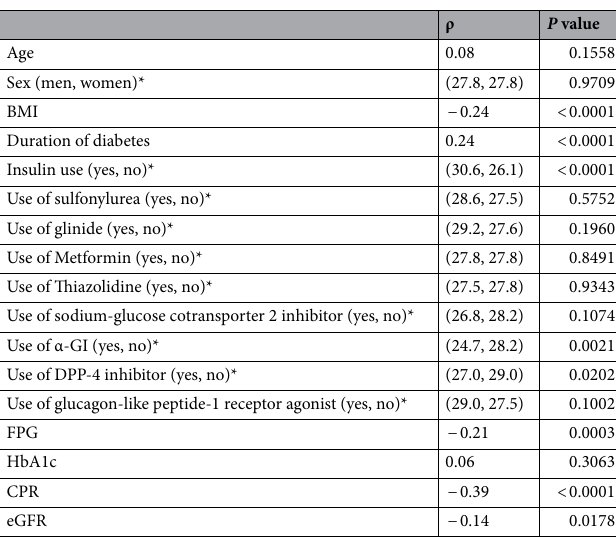
Table 2. Correlations between CV and clinical factors. Spearman rank-order correlation was used to determine the strength of the relationships. CV coefficient of variation, BMI body mass index, α-GI alpha- glucosidase inhibitor, DPP-4 dipeptidyl peptidase-4, FPG fasting plasma glucose, CPR C-peptide, eGFR estimated glomerular filtration rate. *The Mann–Whitney test was used for bivariate analysis of the relationship between CV and the clinical factor. The results are median